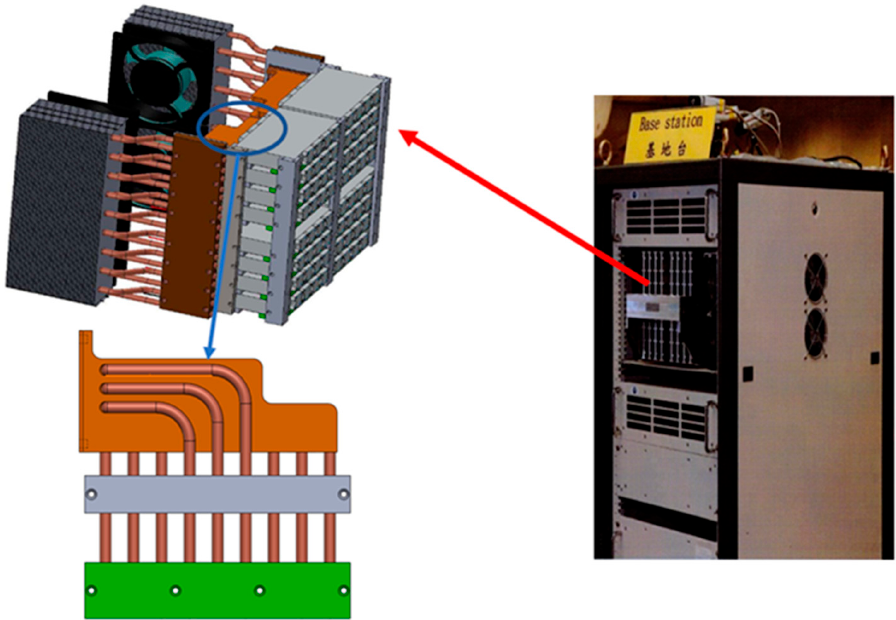
Figure 1. 5G Communication System Structure and Heat Dissipation Module Configuration.